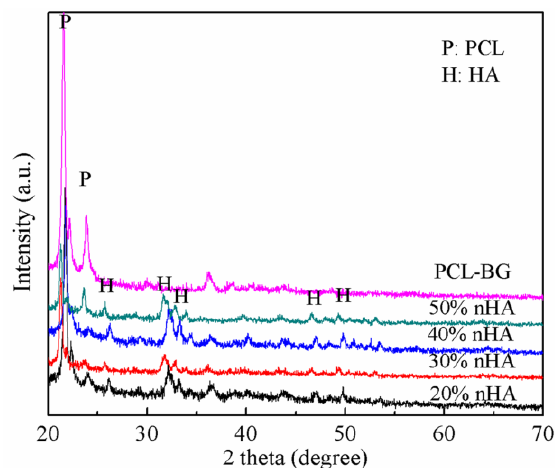
Figure 2. XRD patterns of the nHA-PBP hybrid membranes with different nHA contents.